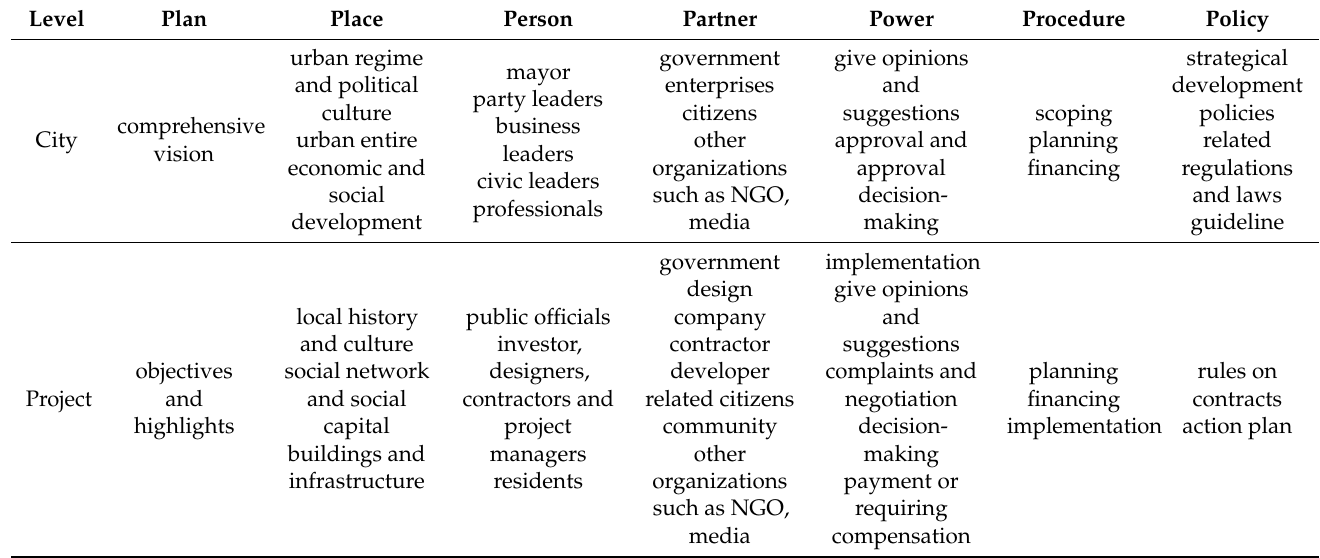
Table 3. The keywords of the 8p model in different